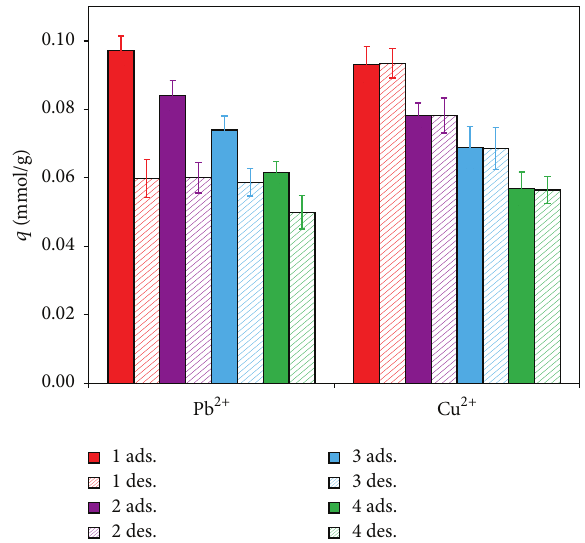
Figure 2: Adsorption-desorption cycles of Pb 2+ and Cu 2+ using citric acid. Experimental conditions: 0.1mM initial metal concen- tration, pH 4.5, and 25 ∘ C. Error bars represent standard deviation of triplicate